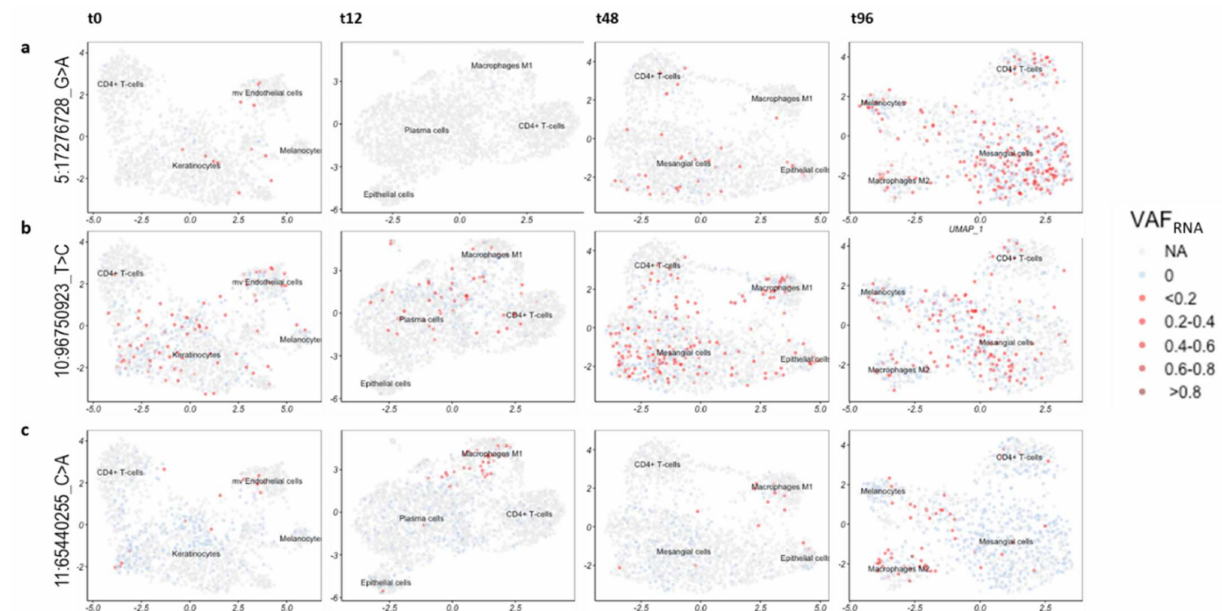
Figure 5. Two-dimensional UMAP projections with quantitative visualization (red) of sceSNVs VAF RNA . The light blue color indicates that the position is covered by at least 3 unique sequencing reads bearing the reference nucleotide, thereby signifying non-0 expression at the position. ( a ). SNV rs1161976348 (5:17276721_G > A) in the 3’-UTR of the gene BASP1 . A higher proportion of cells appear to express the SNV at later time-points post-anti-cancer treatment, especially at t96. ( b ). Novel intergenic SNV (10:96750923_T > C) showing a relatively even distribution across the different cell types and clusters of the 4 post-treatment time-points. ( c ). Novel SNV positioned at 11:65440255 (C > A) in a non-coding exon of the gene NEAT1 , expressed preferentially in the microphages.